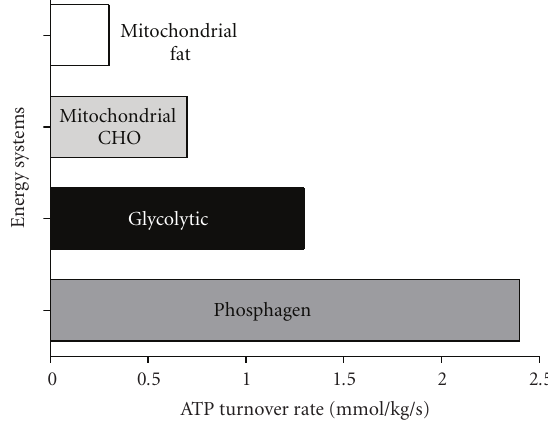
Figure 5: Maximal rates of ATP regeneration from the energy systems of skeletal muscle. Adapted from Sahlin et al.